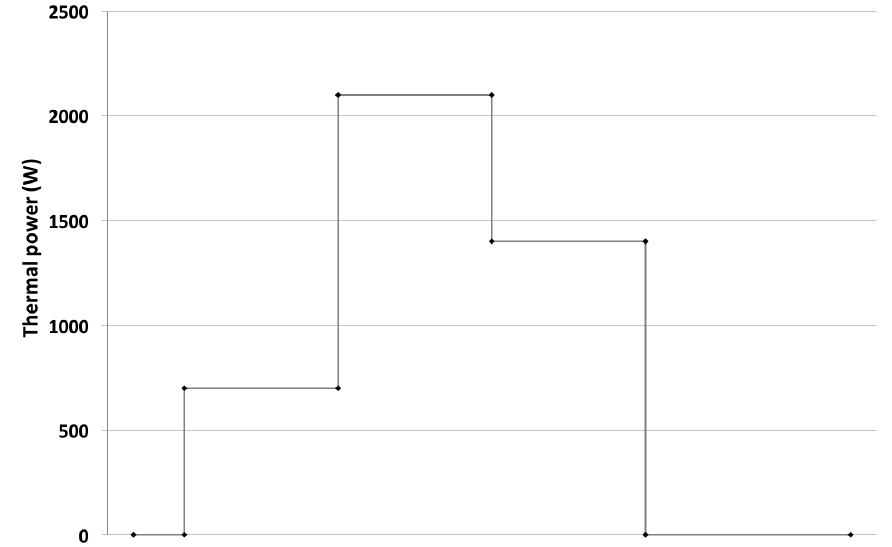
Figure 4. Schematic presentation of the thermal leaps over time (5 days each one).